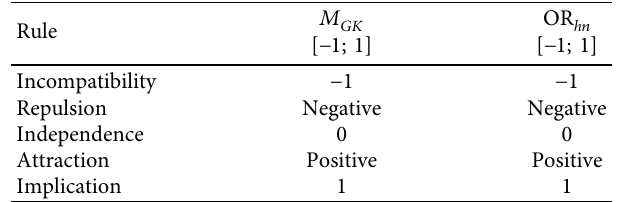
Table 4: The behaviour of the quality measures M the reference situations.